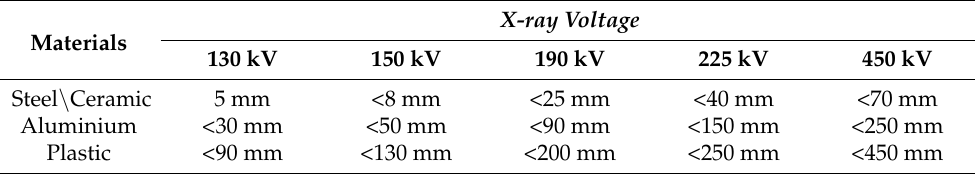
Table 1. Maximum thicknesses producing low signal-to-noise ratios related to X-ray